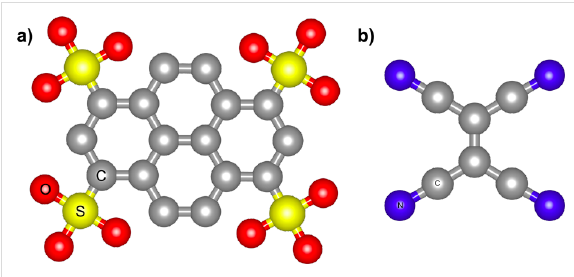
Figure 4: Molecular geometry of tetrafluorotetracyanoquinodimethane (F 4 -TCNQ).